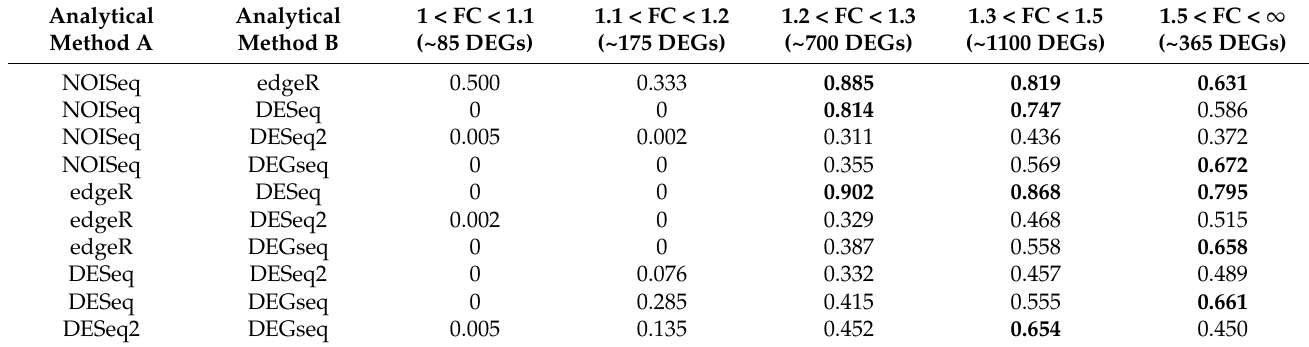
Table 4. Concordance between analytic methods of RNA sequencing according to ranges of gene expression fold changes (FC) between two conditions. The low concordance observed in most FC ranges illustrate the “analytical bias of methods” described in Table 1. Indeed, if the same method is used for prediction in one dataset and validation in a distinct dataset (isomorphic evaluation), the evaluation is considered anticonservative as it measures the reproducibility of true positive and false positive results (analytical biases) rather than a measure of accuracy. In addition, the table results illustrate the difficulty to create a conservative reference standard for which the analytical method would be independent from the predictive method (heteromorphic evaluation); there is no single method that would be the best choice “a priori” to evaluate a new method. Legend: Since the Jaccard Index is symmetric, for any two techniques, we present the Jaccard Indices for the 5 ( ) = 10 total possible pairwise combinations between the five analytical methods evaluated across the different fold 2 change regions. DEGs were calculated using five repeated samples of MCF7 breast cancer cell lines exposed to estrogen and five unexposed samples. The high concordance for each pairwise comparison is bolded (Jaccard Index > 0.6) and shown in a larger font. (Legend: In the manuscript and figure, we represent FC for upregulated genes and 1/FC for downregulated